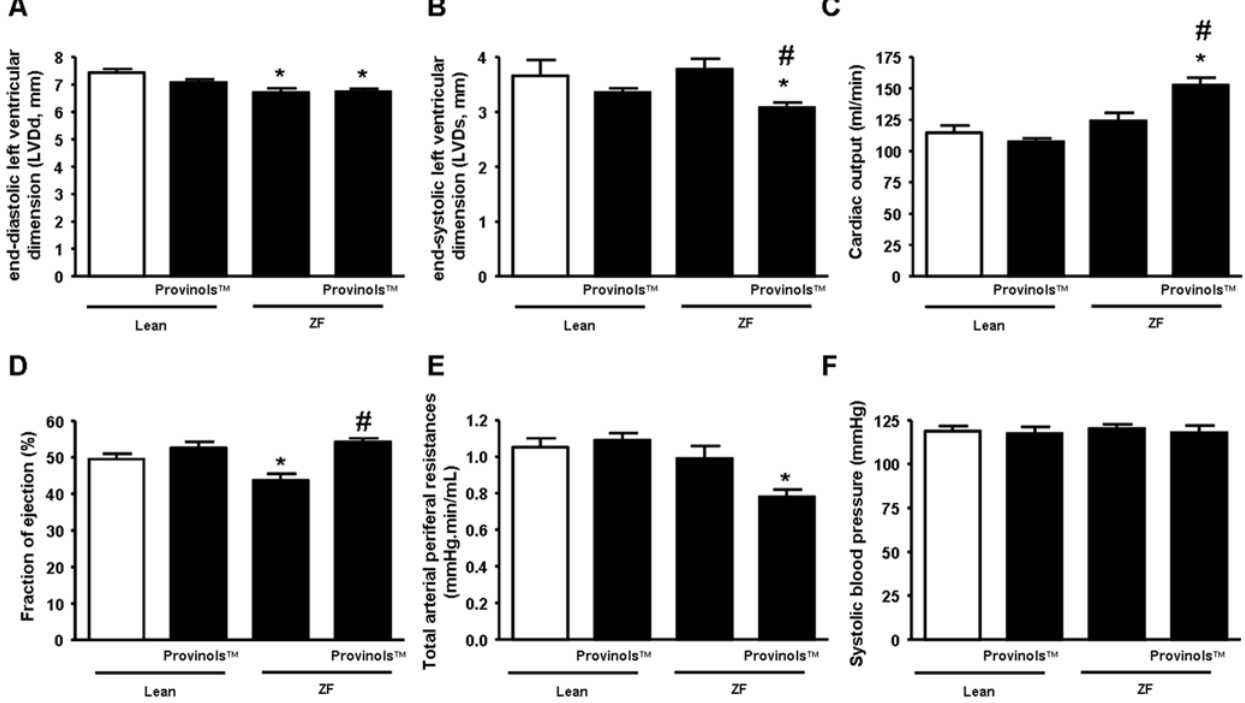
Figure 2. Provinols TM improve cardiac function in ZF rats. Echocardiography measurements of diastolic left ventricular dimension (LVDd), systolic left ventricular dimension (LVDs), cardiac output and fraction of ejection (A–D). Systolic blood pressure was evaluated using tail-cuff technique (E). Total arterial peripheral resistances were calculated from blood pressure and cardiac output (F). Values are means 6 SEM ( n =6). * P , 0.05 Zucker fatty (ZF) rats vs. lean rats; # P , 0.05 ZF + Provinols TM rats vs. ZF